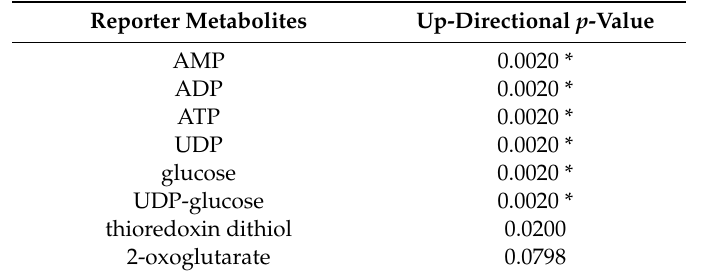
Table 3. List of reporter metabolites of C. militaris at the light-programming condition. Reporter